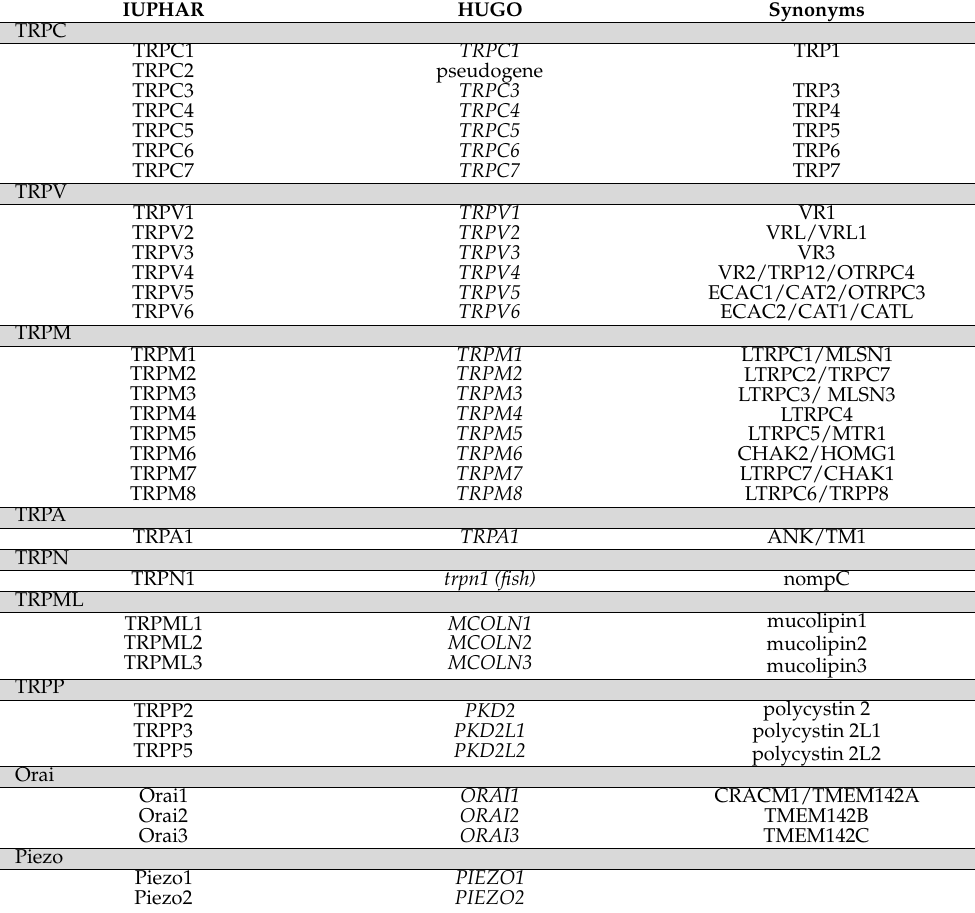
Table 2. Nomenclature of the Ca 2+ -permeable channel